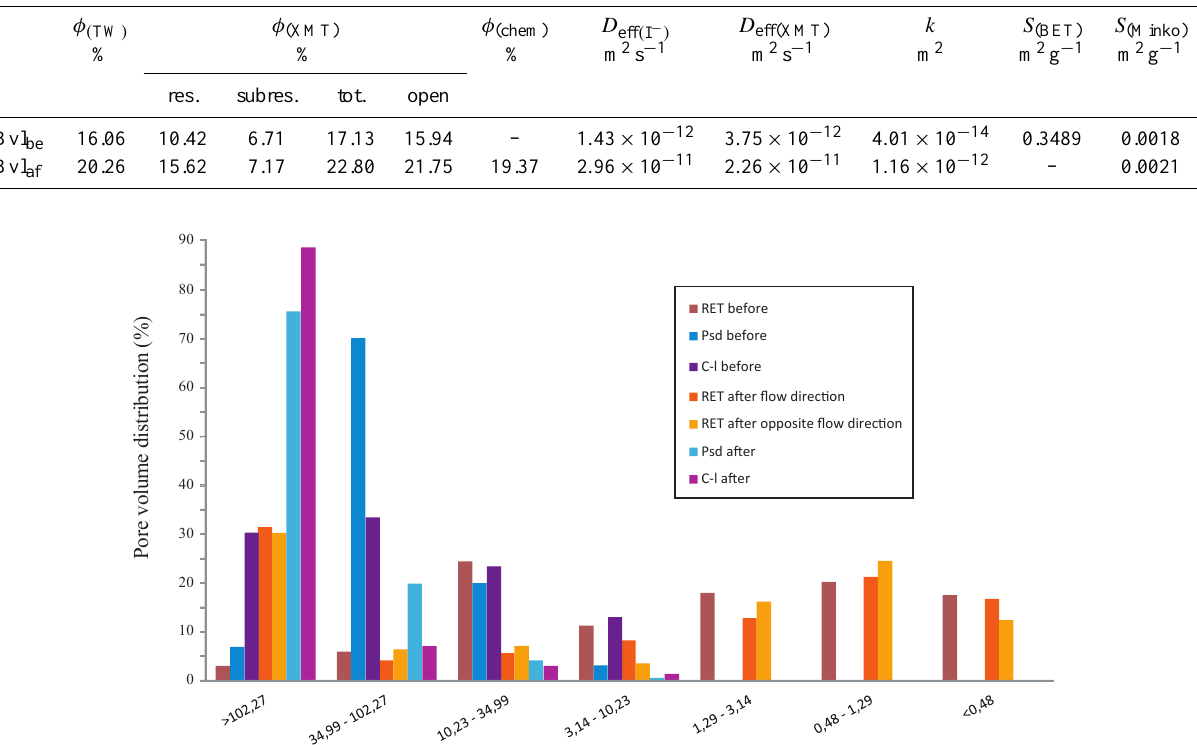
Table 2. Determined porosities [%] (final one by mass balance calculation (chem), before and after by triple weighing technique (TW), and before and after as well as total (tot.), effective (open), resolved (res.) and sub-resolved (subres.) by XMT images (XMT)), effective diffusion interface (from BET measurement and XMT images (Minko)) for samples Bvl be and Bvl af .